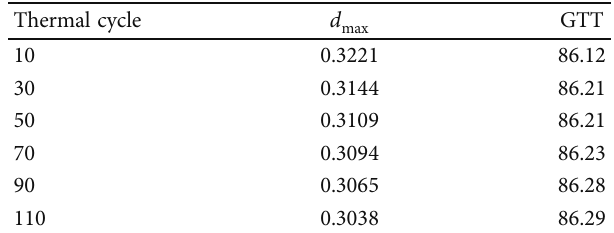
Table 2: E ff ect of damping factor and glass transition temperature e ff ect on thermal adsorption of an epoxy